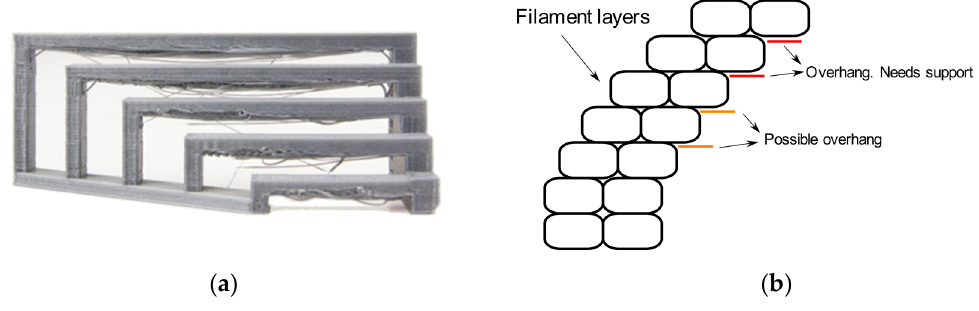
Figure 2. Limitation examples: ( a ) bridging; ( b ) overhangs.